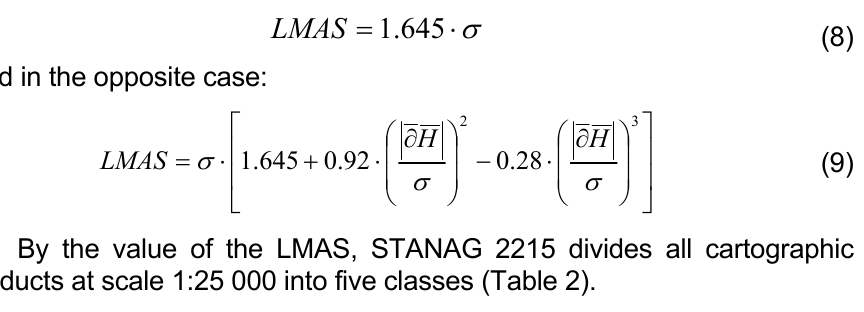
Table 2 – The cartographic products classification by vertical positional accuracy ( α